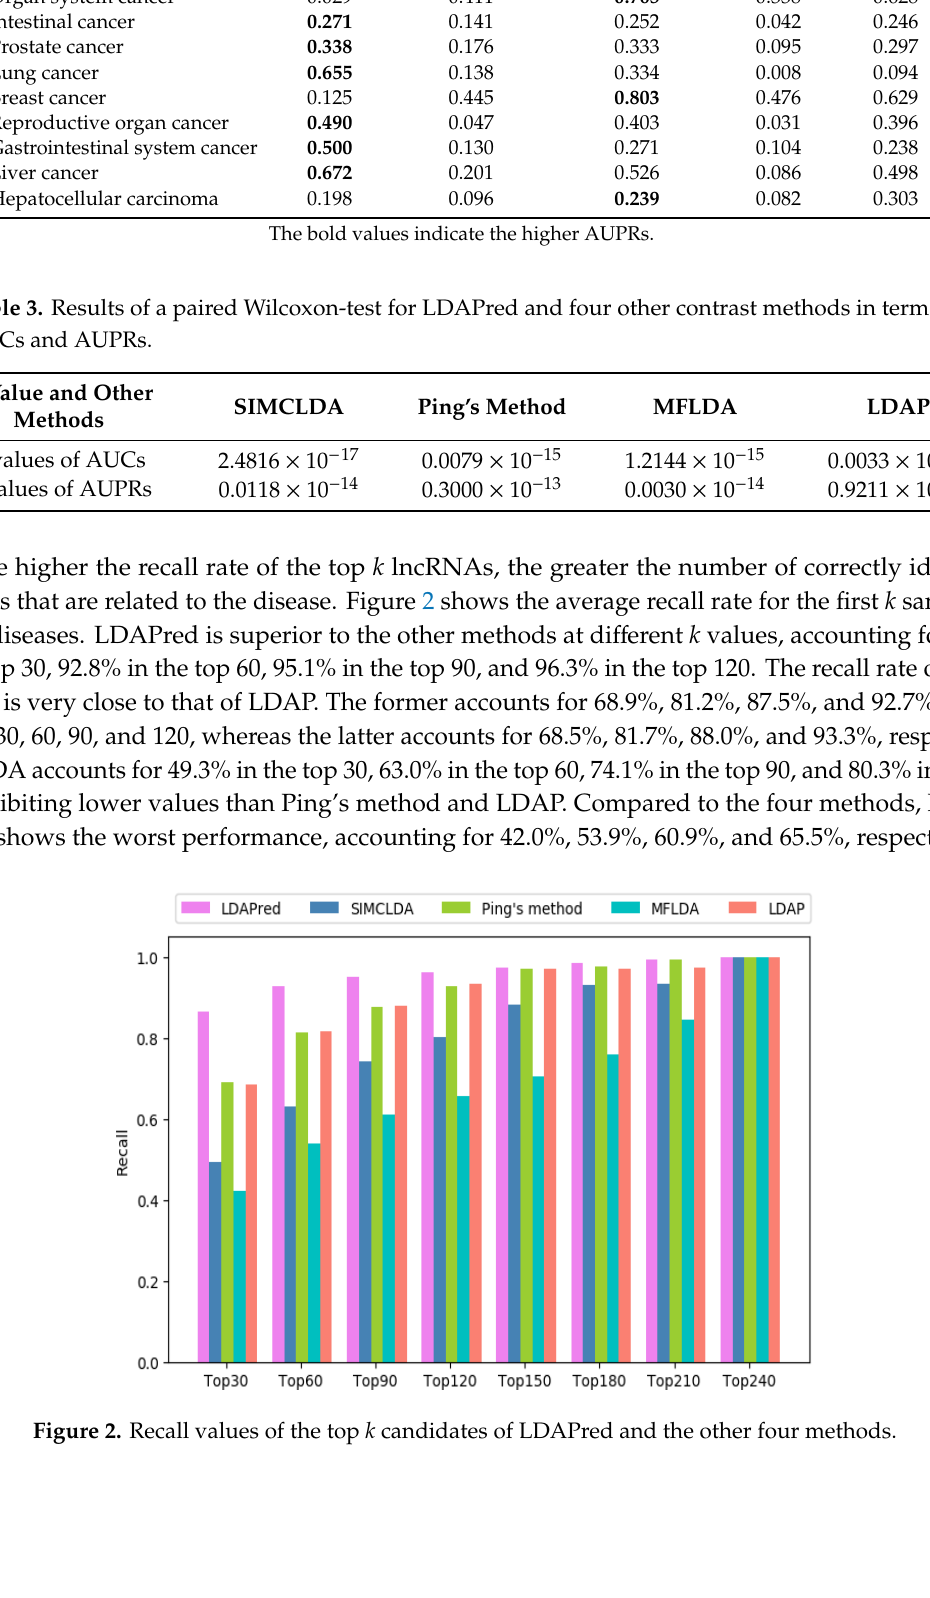
Table 2. Area under PR curves (AUPR) of LDAPred and other methods for all diseases and 10 well-characterized diseases.